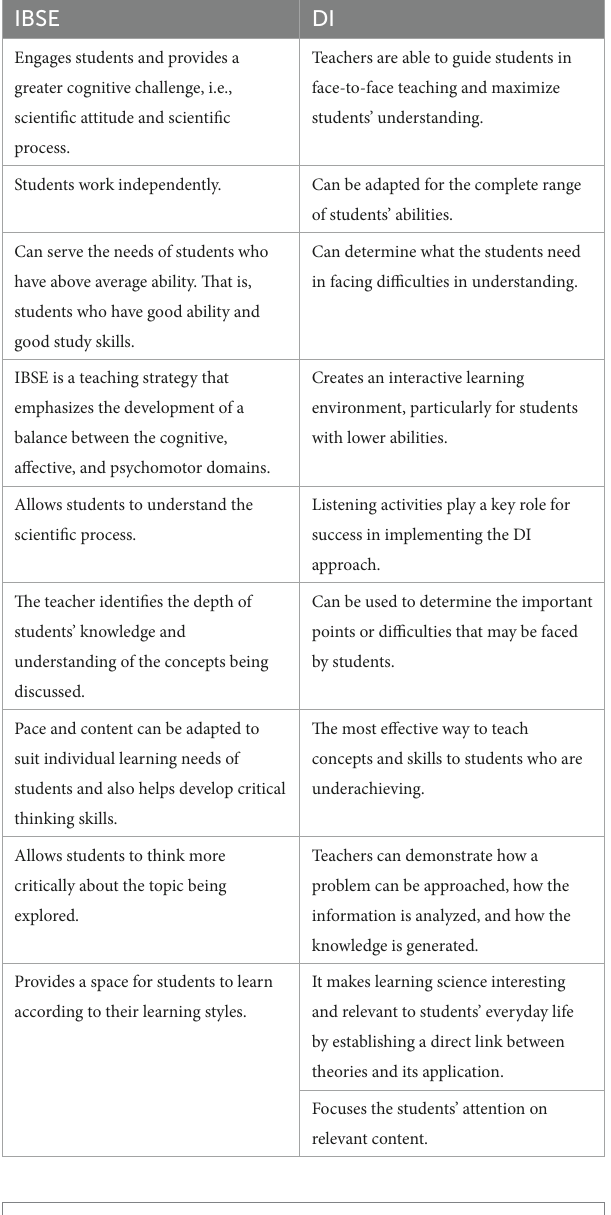
TABLE 4 Summary of the benefits of inquiry based science education (IBSE) and direct instruction (DI) in teaching physics as outlined by teachers who participated in the study.